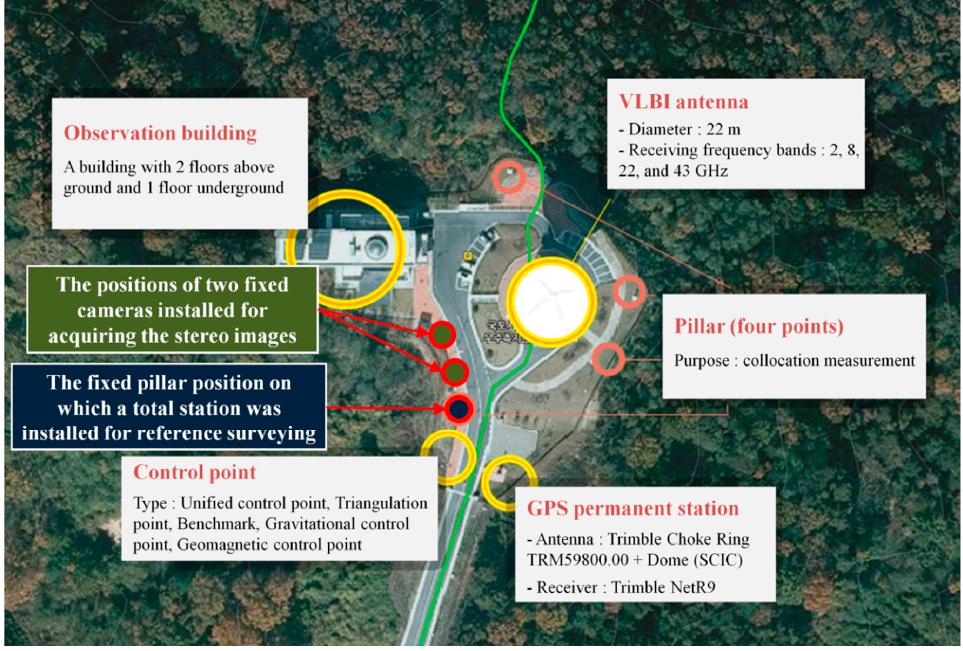
Figure 1. Facility configuration at the Space Geodetic Observation Center (SGOC).